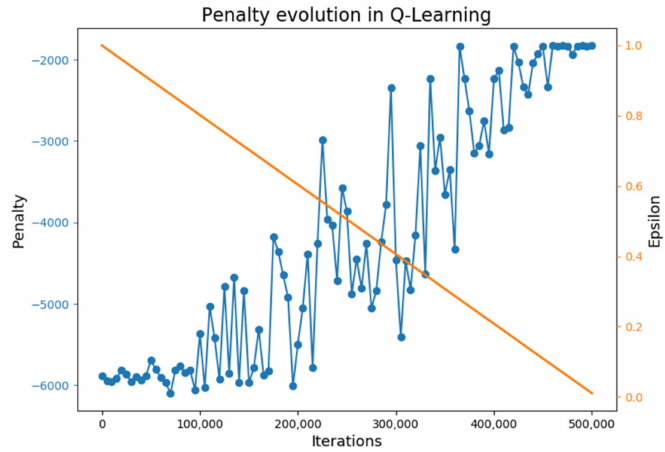
Figure 7. Q-Learning agent’s policy improvement during